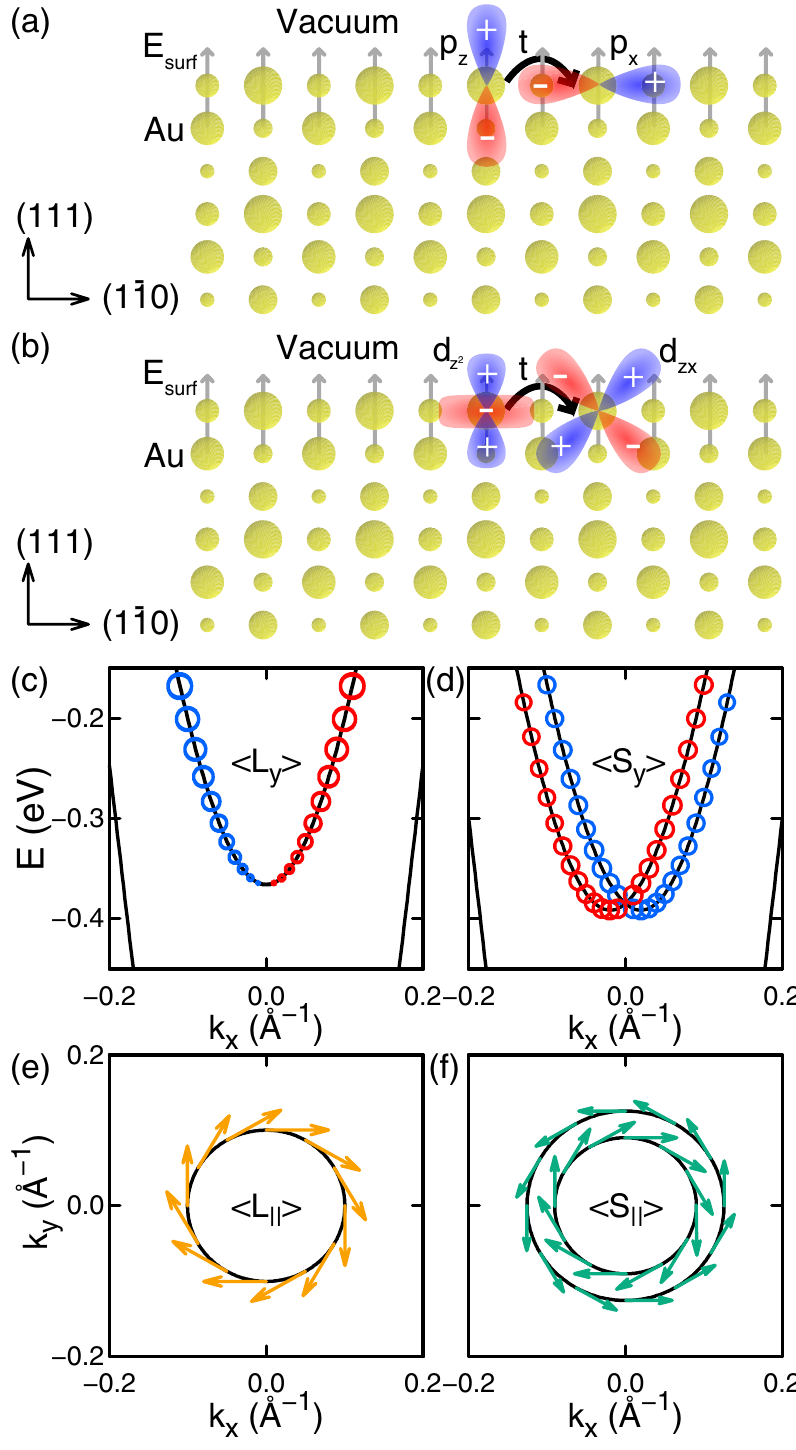
Figure 4. Au (111) surface. ( a ) Schematic representation of the interatomic hopping energy between p z and p x orbitals and ( b ) that between d and d zx orbitals of topmost surface Au atoms. The x axis is along [110] direction z 2 and the z axis is along [111] direction. ( c ) The spin-degenerate surface band near Γ obtained by DFT calculation without considering SOI. The size of open dots is proportional to | 〈 L y 〉 |. ( d ) The spin-split surface bands near Γ obtained with considering SOI. The size of open dots is proportional to | 〈 S y 〉 |. In ( c , d ), blue and red dots are for positive and negative values, respectively. ( e , f ) Constant-energy cut of the surface band(s) at − 0.2 eV near Γ ( e ) without SOI and ( f ) with SOI. Arrows are in-plane components of OAM obtained without SOI in ( e ) and those of the spin with SOI in ( f